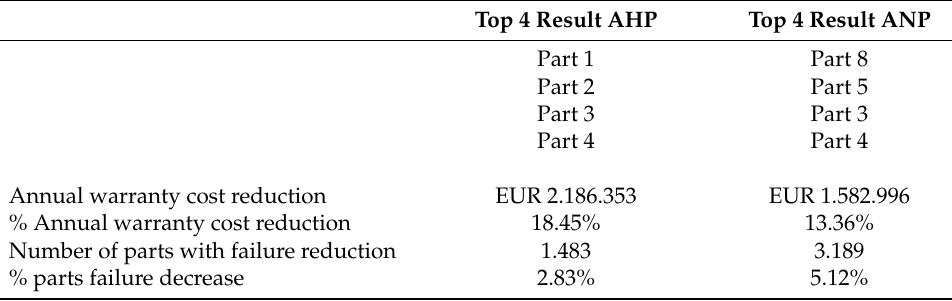
Table 11. Comparison ANP and AHP